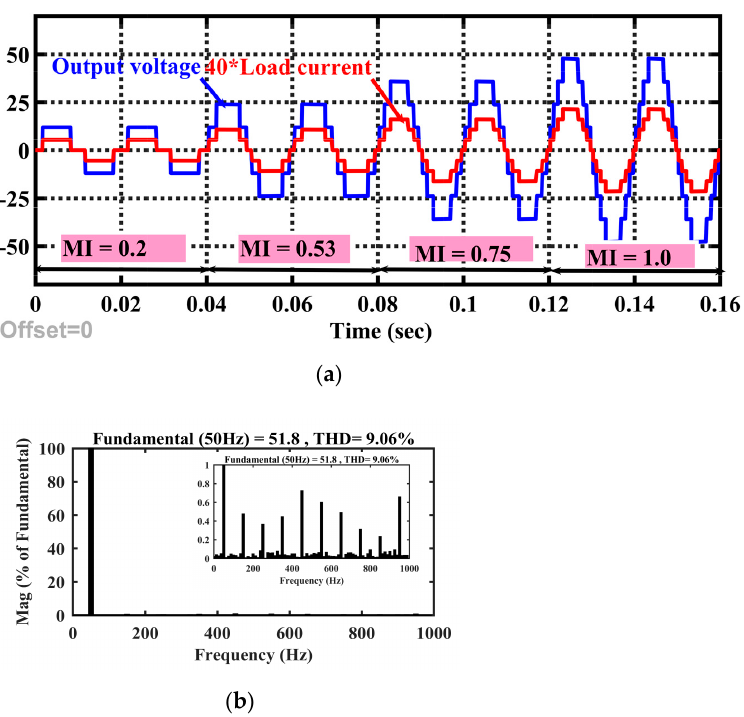
Figure 9. ( a ) Output voltage and current for dynamic change in modulation index and ( b ) total harmonics distortion (THD) in output voltage for symmetric configuration.